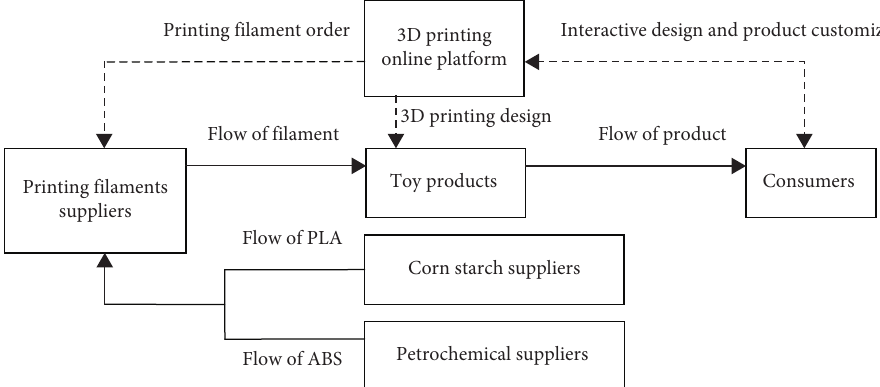
Figure 2: US consumers trust an online platform to print personalized toys. Data source: authors.